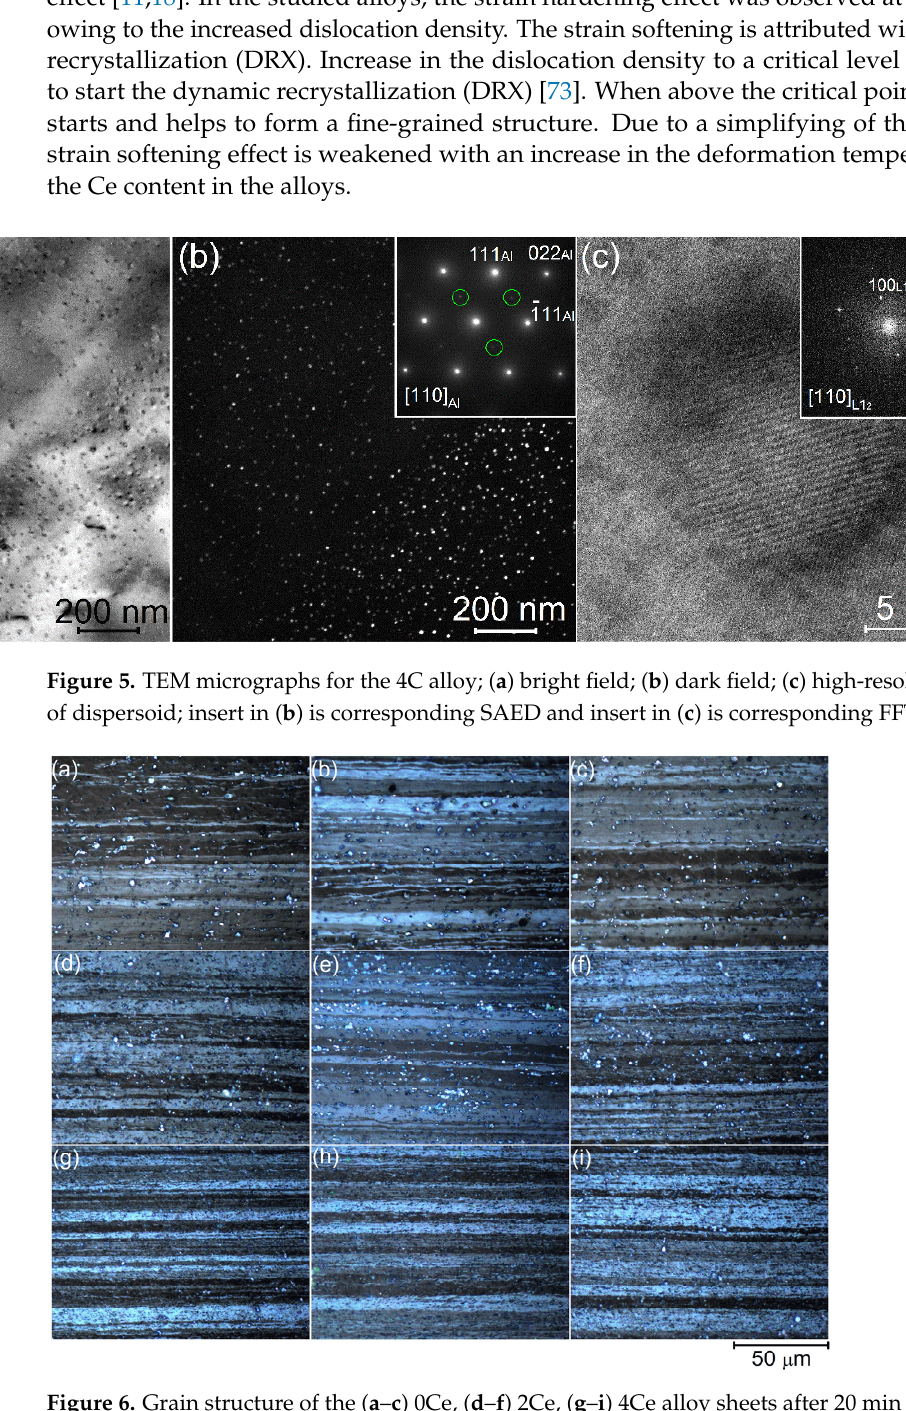
Figure 4. SEM-BSE images of the studied alloys in the as-cold rolled state and corresponded particle size distribution histograms.